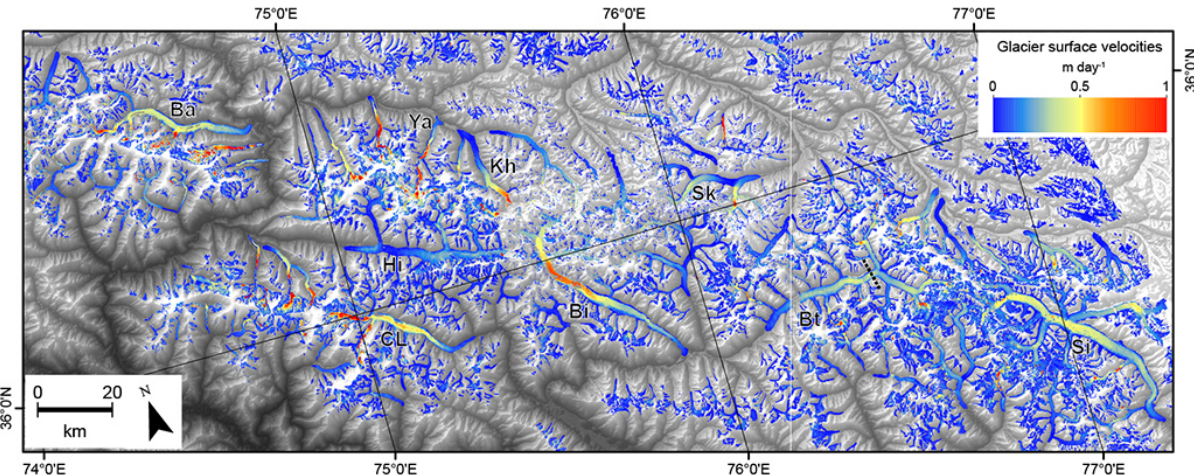
Figure 5. Compiled surface velocities mosaic of the Karakoram. Priority has been given to the highest resolution and best coverage. Data takes are between 2007 and 2011 from TerraSAR-X, ALOS PALSAR, and Envisat ASAR. The dashed line at Baltoro Glacier marks the Con- cordia cross profile mentioned in the text. Abbreviations: Ba – Batura Glacier, Bi – Biafo Glacier, Bt – Baltoro Glacier, CL – Chogo Lungma Glacier, Hi – Hispar Glacier, Khv – ,Khurdopin Glacier, Si – Siachen Glacier, Sk – Skamri Glacier, Ya – Yazghil Glacier. Background: SRTM DEM. Higher resolved subsets are shown in the Supplement (Figs.